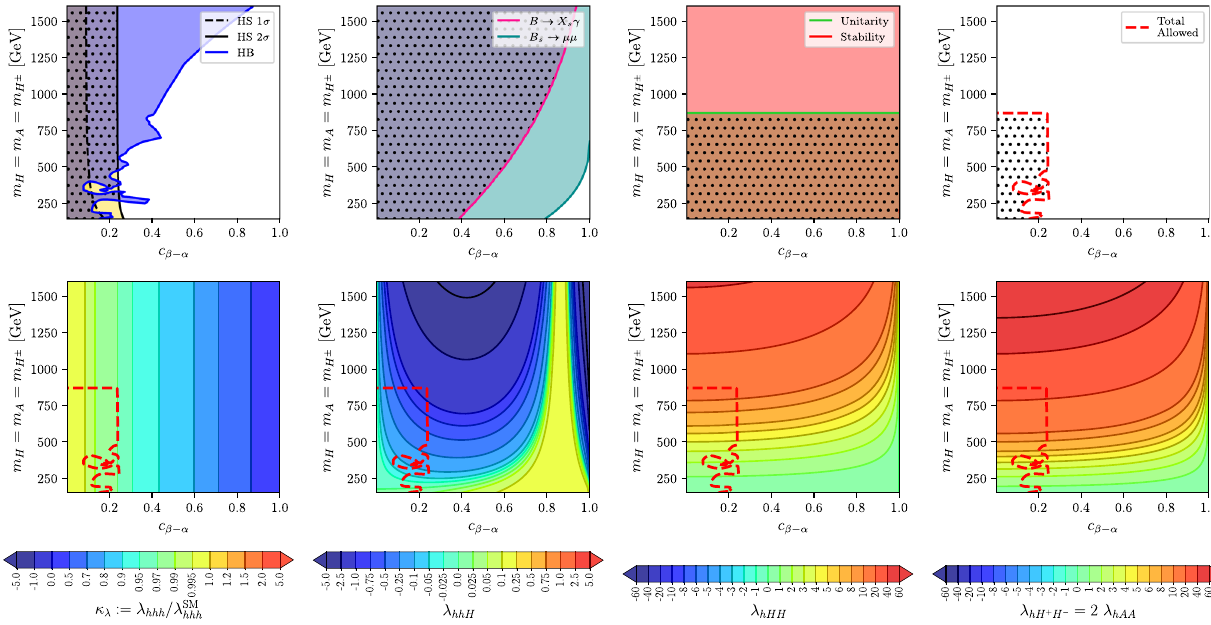
fixed by Eq. (6) 12